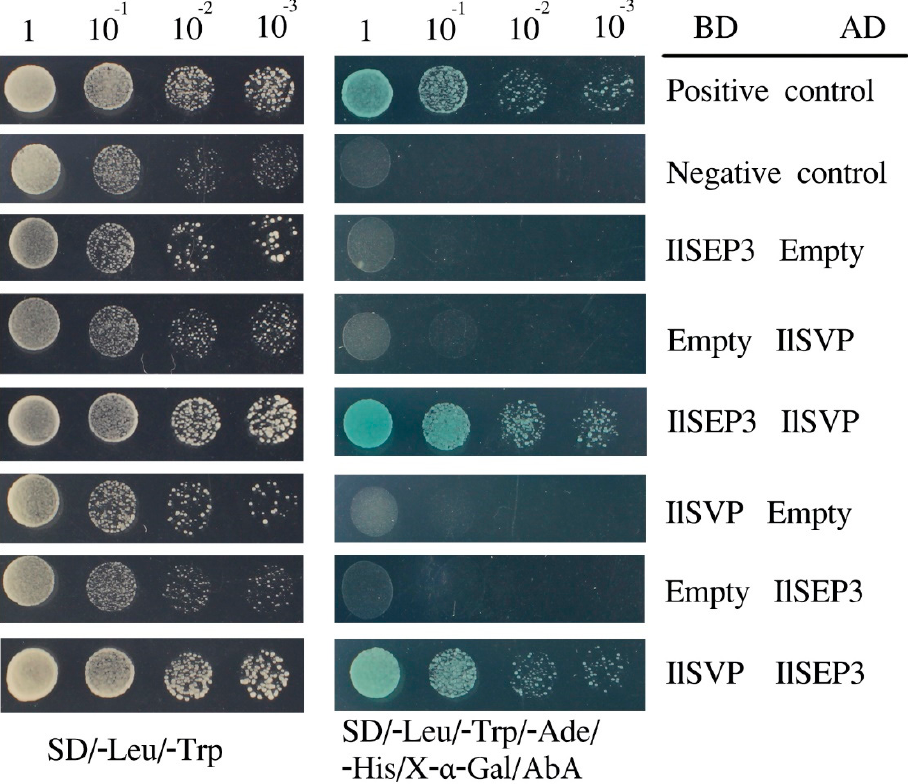
Figure 5. Interaction between IlSEP3 and IlSVP by yeast-two-hybrid. Numbers on top indicate dilution factors. The relative interaction strengths were determined by increasing dilution of yeast colonies. AD, active domain; BD binding domain. For co-transformation, eight groups were assessed: the test group (pGBKT7-IlSEP3 and pGADT7-IlSVP), (pGBKT7-IlSVP and pGADT7-IlSEP3), control for self-activation (pGBKT7-IlSEP3 and empty), (pGBKT7-IlSVP and empty), (empty and pGADT7- IlSVP), (empty and pGADT7-IlSEP3), positive control (pGADT7-T and pGBKT7-53), and negative control (pGADT7-T and pGBKT7-Lam). Transformed cells were diluted and then grown on either SD/-Trp/-Leu or SD/-Trp/-Leu/-Ade/-His/X- α -Gal/ABA at 28 °C for 48 h.